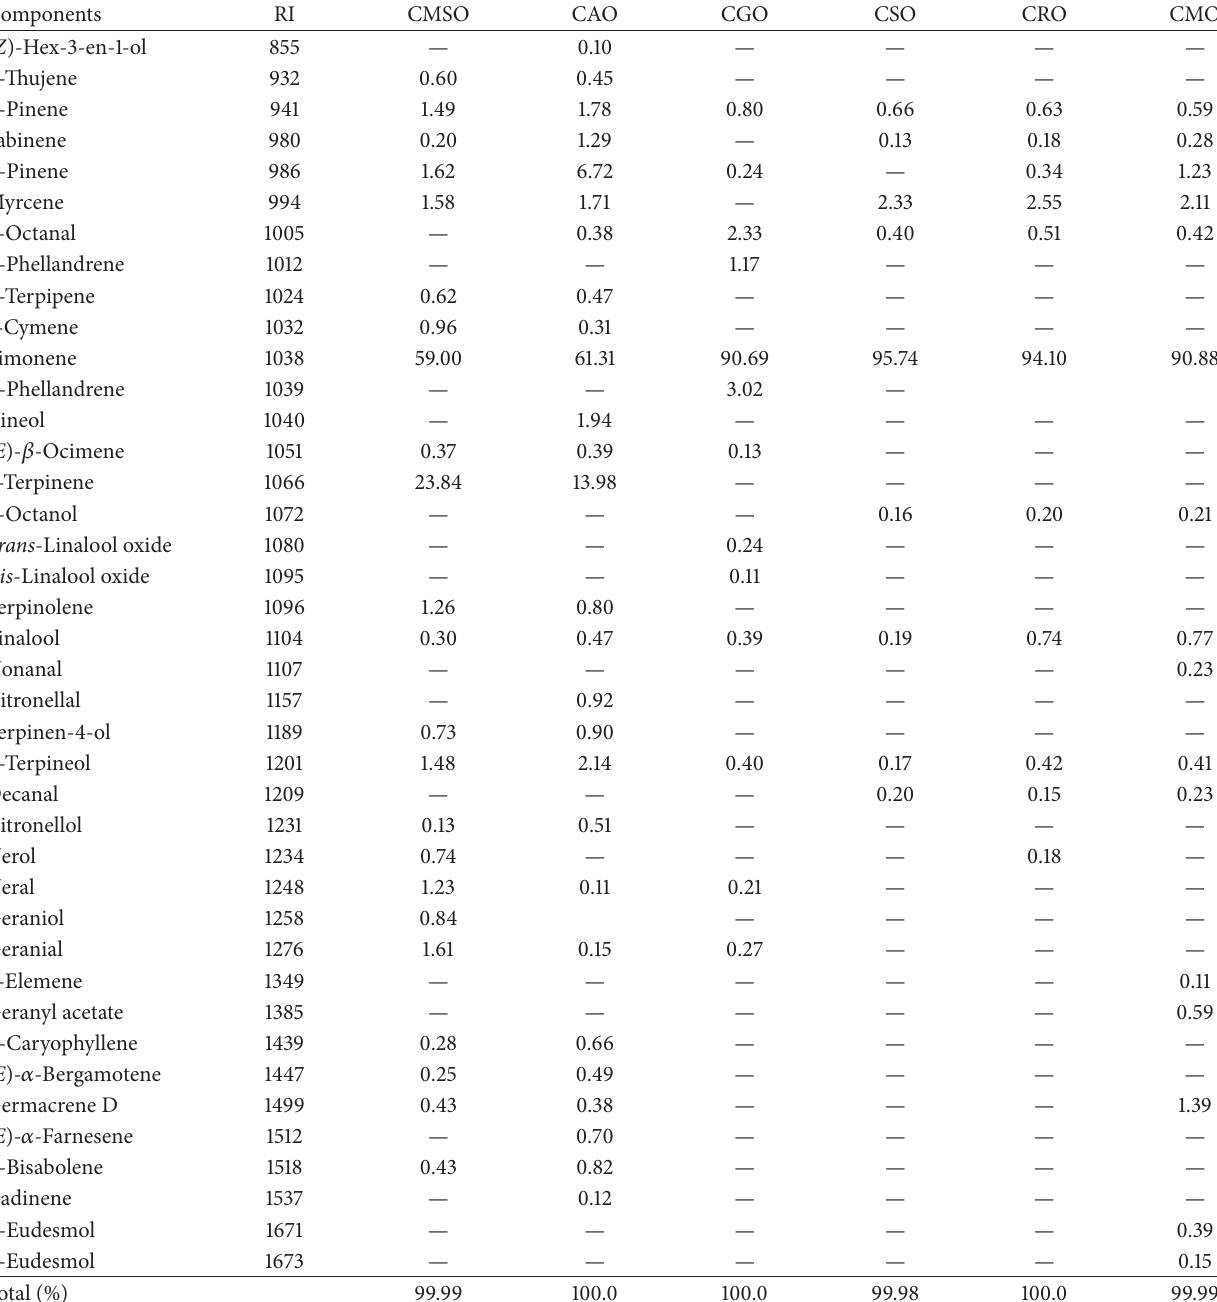
Table 1: Yield and composition of the essential oil of six Citrus